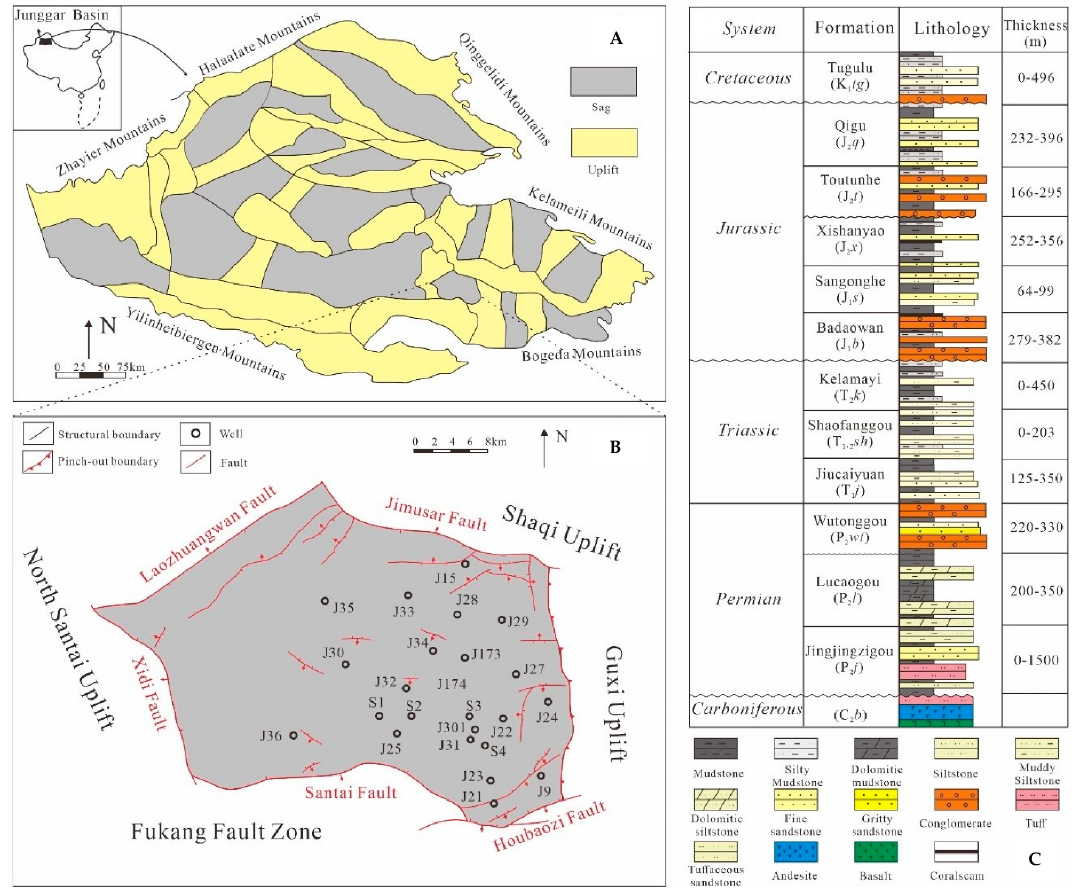
Figure 1. Diagrams showing ( A ) Junggar tectonic units and location of the Jimusar Depression, ( B ) structure and well location map of the Jimsar Depression, and ( C ) the stratigraphic sequence from Upper Caboniferous to Lower Cretaceous in the Jimsar Depression (modified from [40]).